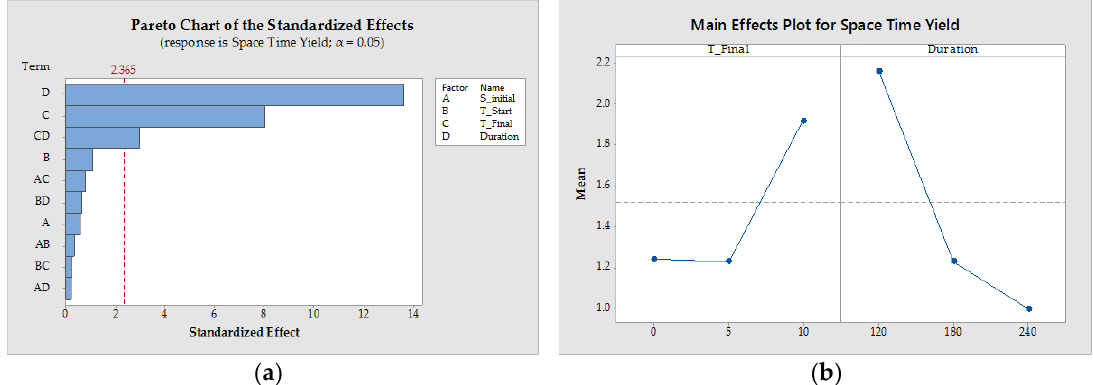
Figure 9. Influences on x 50 : ( a ) significances and ( b ) main effects.